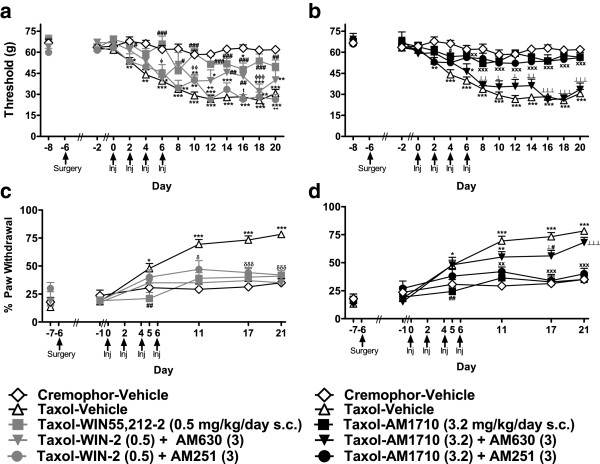
Pharmacological specificity of cannabinoid agonist-induced suppression of paclitaxel-induced mechanical and cold allodynia. a. WIN55,212-2 (0.5 mg/kg/day s.c.)-mediated suppression of paclitaxel-induced mechanical allodynia was dominated by CB1 receptor activation with some involvement of CB2 receptors. b. The AM1710 (3.2 mg/kg/day s.c.)-induced suppression of paclitaxel-induced mechanical allodynia was blocked by AM630 (3 mg/kg/day s.c.) but not AM251 (3 mg/kg/day s.c.)). c. Neither AM630 (3 mg/kg/day s.c.) nor AM251 (3 mg/kg/day s.c.) reliably altered the anti-allodynic effects of WIN55,212-2 (0.5 mg/kg/day s.c.) following acetone application. d. AM630 (3 mg/kg/day s.c.), but not AM251 (3 mg/kg/day s.c.), blocked the anti-allodynic effects of AM1710 (3.2 mg/kg/day s.c.) to cold stimulation. *P < 0.05, **P < 0.01, ***P < 0.001 vs. Cremophor-Vehicle, #P < 0.05, ##P < 0.01, ###P < 0.001 vs. Taxol-Vehicle, ++P < 0.01 vs. Taxol-Agonist, xxP < 0.01, xxxP < 0.001 Taxol-Agonist and Taxol-Agonist + AM251 (3) vs. Taxol-Vehicle, tP < 0.05 vs. Taxol-Agonist, Taxol-Agonist + AM630 (3), and Cremophor-Vehicle, ϕP < 0.05, ϕϕP < 0.01, ϕϕϕP < 0.001 Taxol-Agonist + AM630 (3) and Taxol-Agonist + AM251 (3) vs. Taxol-Agonist, ⟂P < 0.05, ⟂⟂P < 0.01, ⟂⟂⟂P < 0.001 vs. Taxol-Agonist, Taxol-Agonist + AM251 (3), and Cremophor-Vehicle, δP < 0.05, δδδP <0.001 Taxol-Agonist, Taxol-Agonist + AM251 (3), and Taxol-Agonist + AM630 (3) vs. Taxol-Vehicle. Doses are in mg/kg/day s.c. (ANOVA; Dunnett and Tukey post-hoc tests). N = 10–18 per group.